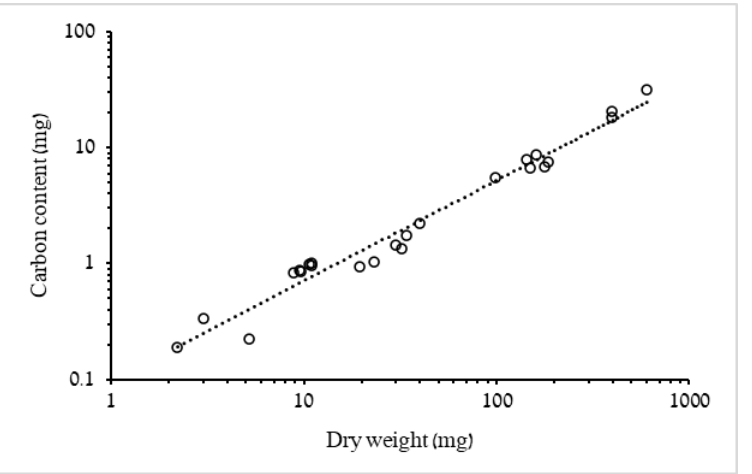
Figure 2. Log–log plots of the relationship between carbon content (C) and total dry weight (DW) of R. nomadica ( n = 24). C = 0.0973*DW 0.8642 , R 2 = 0.969. F 1, 22 = 685.7, p < 0.001.